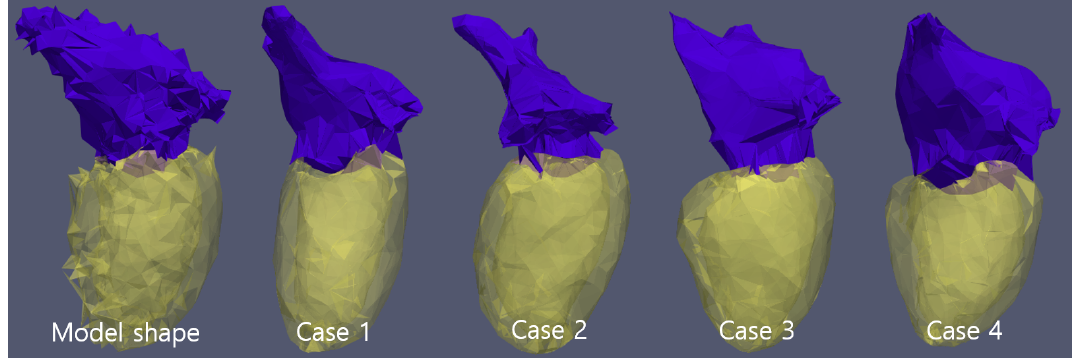
Figure 2. Model tetrahedron set T a and, reconstructed T k of 4 cases. Five cases have the same tetrahedron cell topology and cell